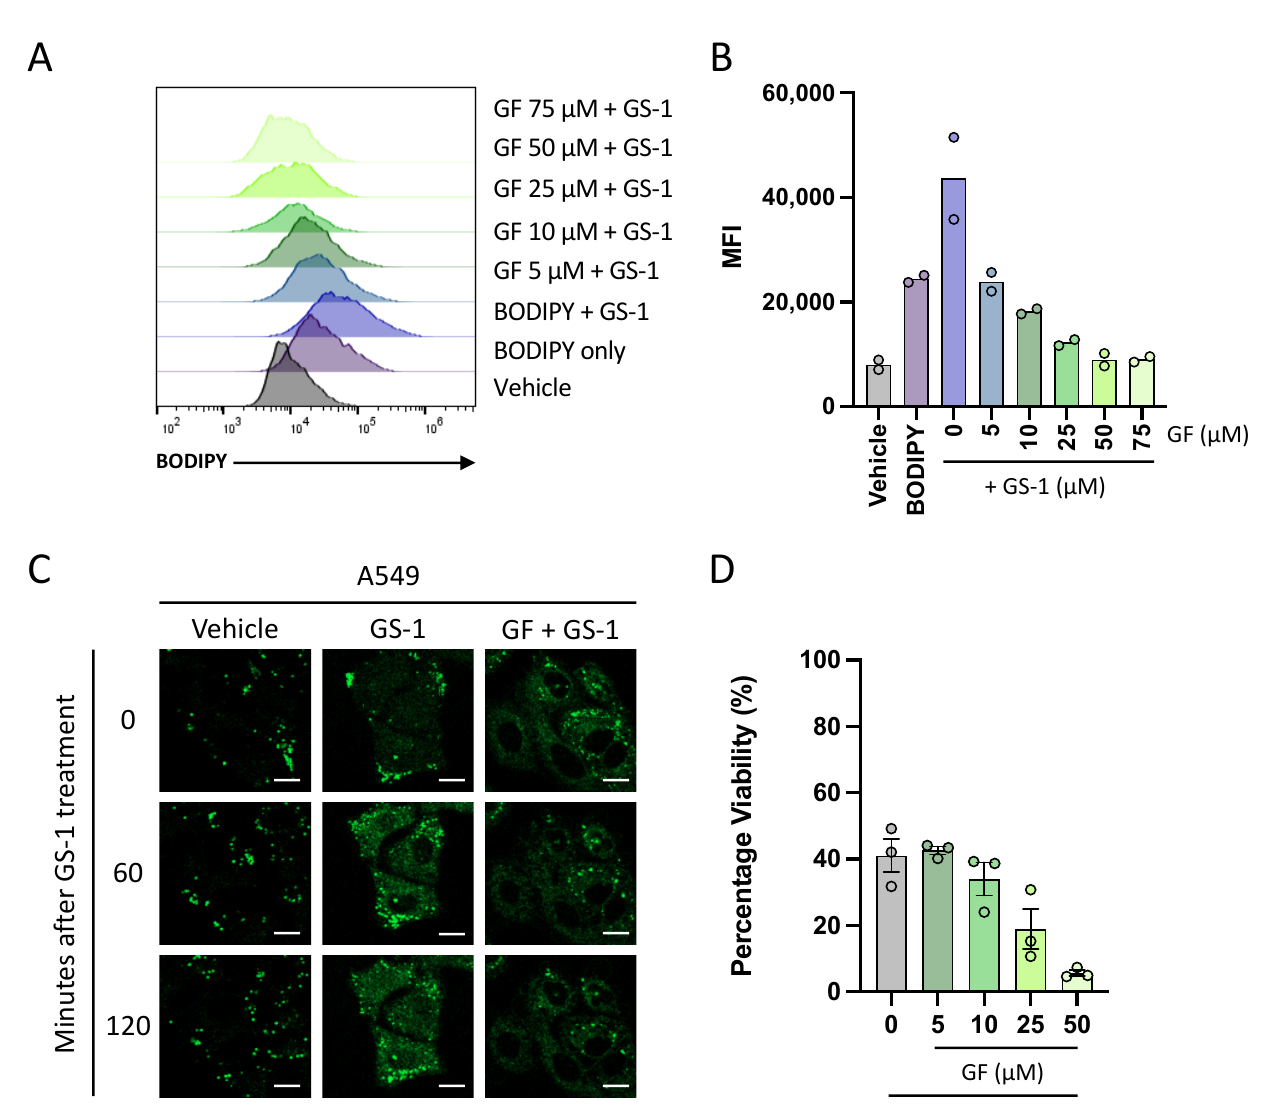
Figure 5. GS-1 likely enters cells via FATP2. ( A ) A549 cells were stained with BODIPY and treated with GS-1 and increasing concentrations of Grassofermata for 4 h. BODIPY levels were plotted as histograms after flow cytometry analysis. BODIPY MFI was then quantified in ( B ) (Representative of n = 3 experiments). ( C ) A549 cells were stained with BODIPY and treated with GS-1 with